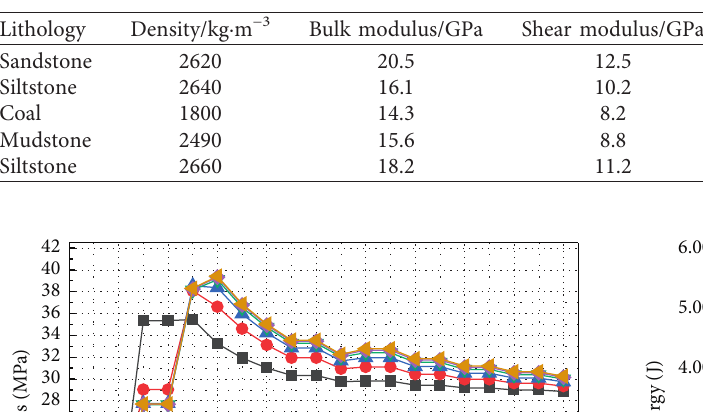
Table 2: Mechanical parameters of coal and rock.